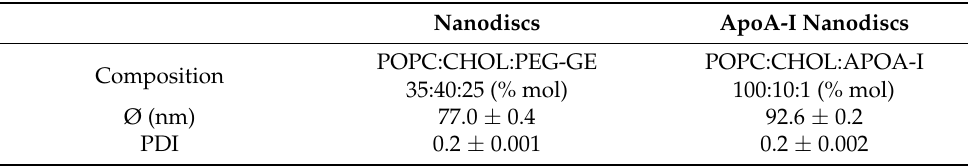
Table 1. Physico-chemical characterization of apoA-I nanodiscs by DLS.